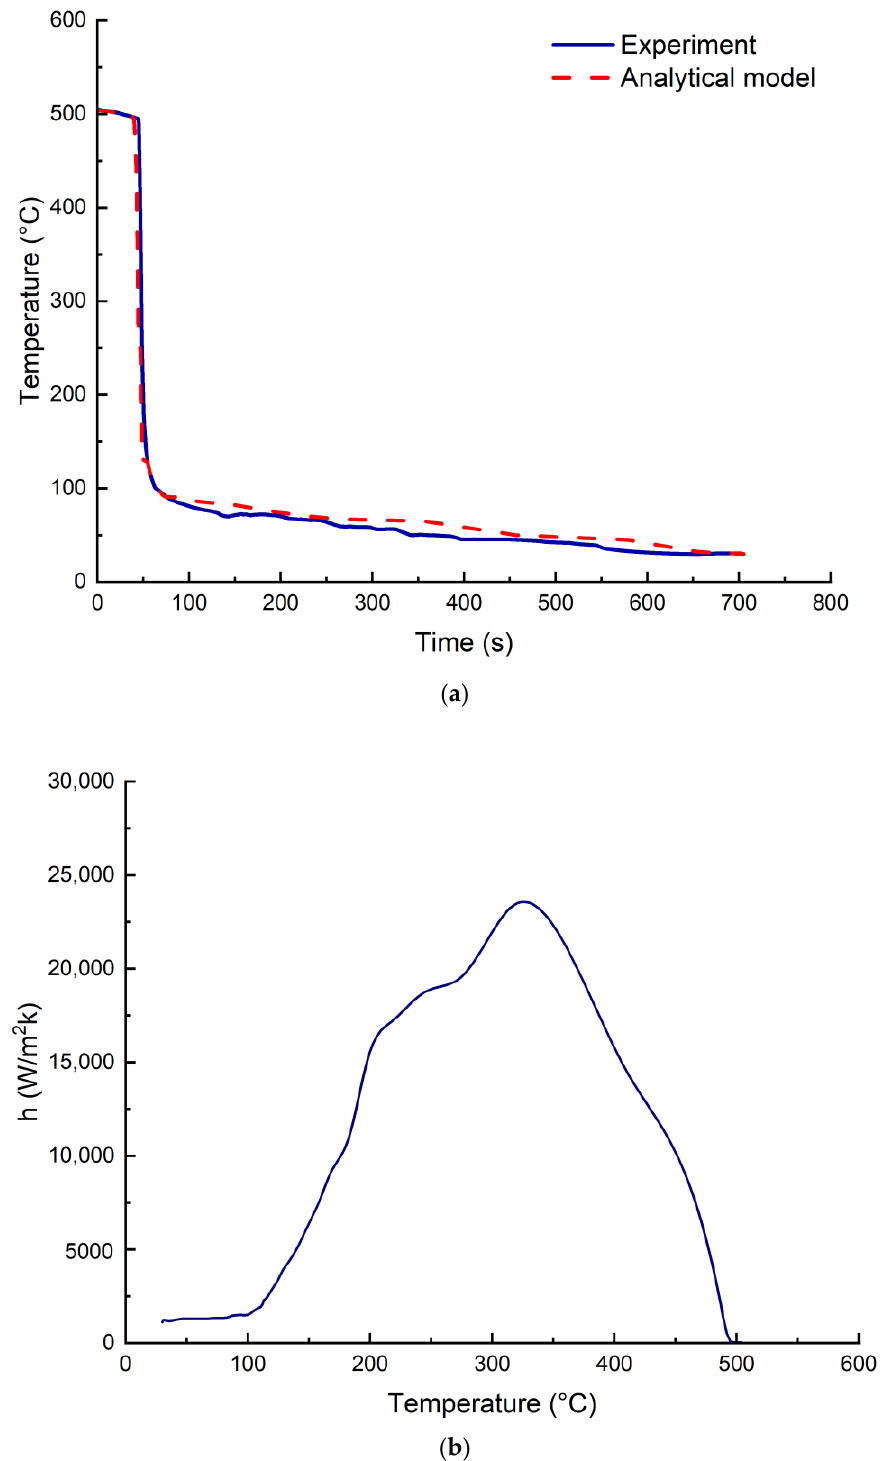
Figure 3. ( a ) Comparison of the analytical and experimental temperature profiles for the water- quenched part of the block. ( b ) The heat transfer coefficient obtained from the analytical analysis.